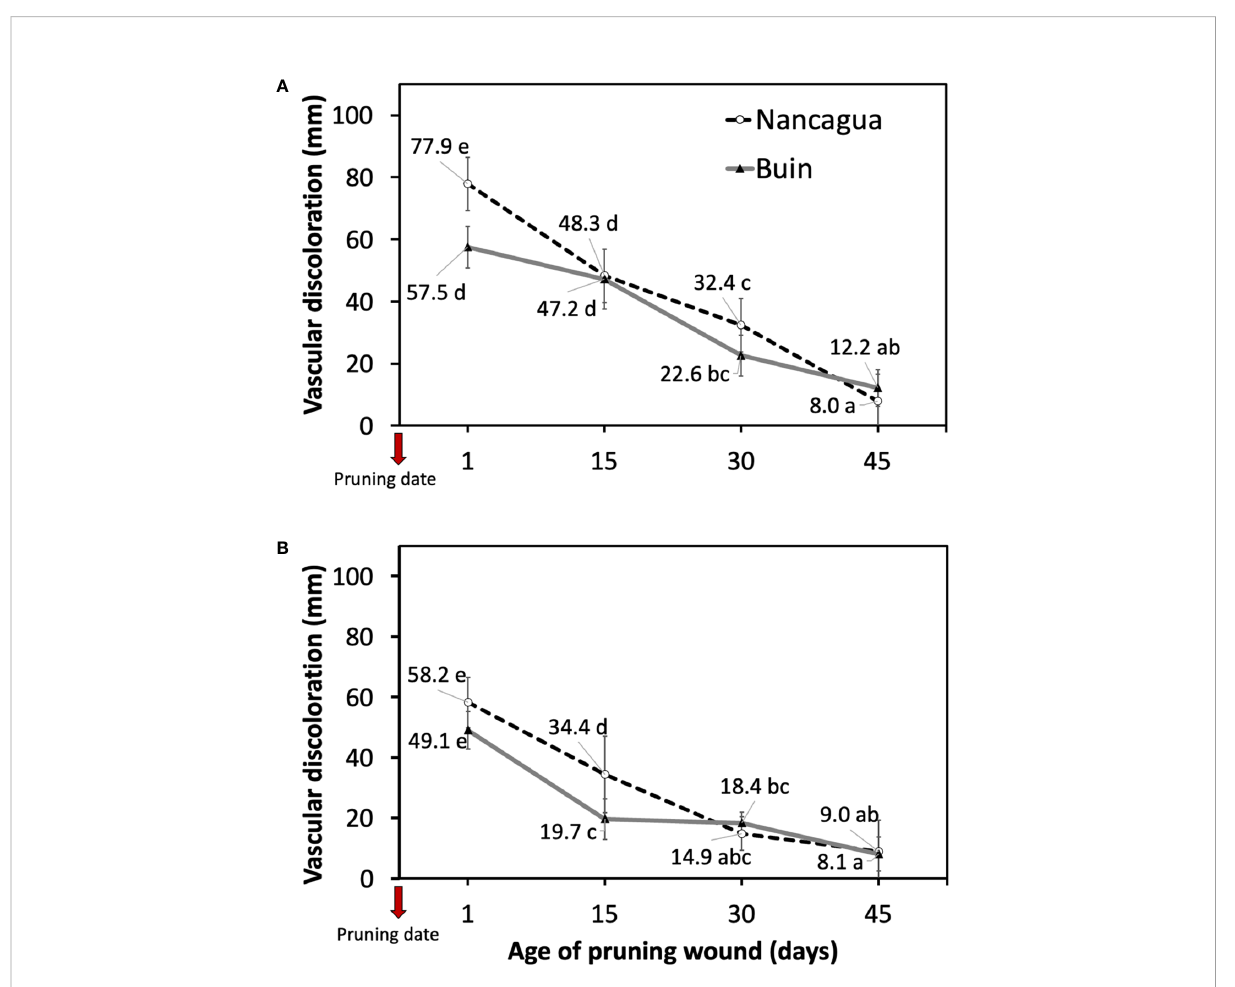
FIGURE 5 Lesions of vascular discoloration expressed as mean (mm) ± standard deviation caused by arti fi cial inoculation of 40 uL of a conidial suspension (10 5 conidia/mL) of Phaeomoniella chlamydospora on pruning wound of different ages of spurs cv. Cabernet Sauvignon at 1, 15, 30, and 45 days after pruning in the commercial vineyards located in Buin (line) and Nancagua (segmented line), during eight months from the dormant season of 2014 (A) and 2015 (B) in Central